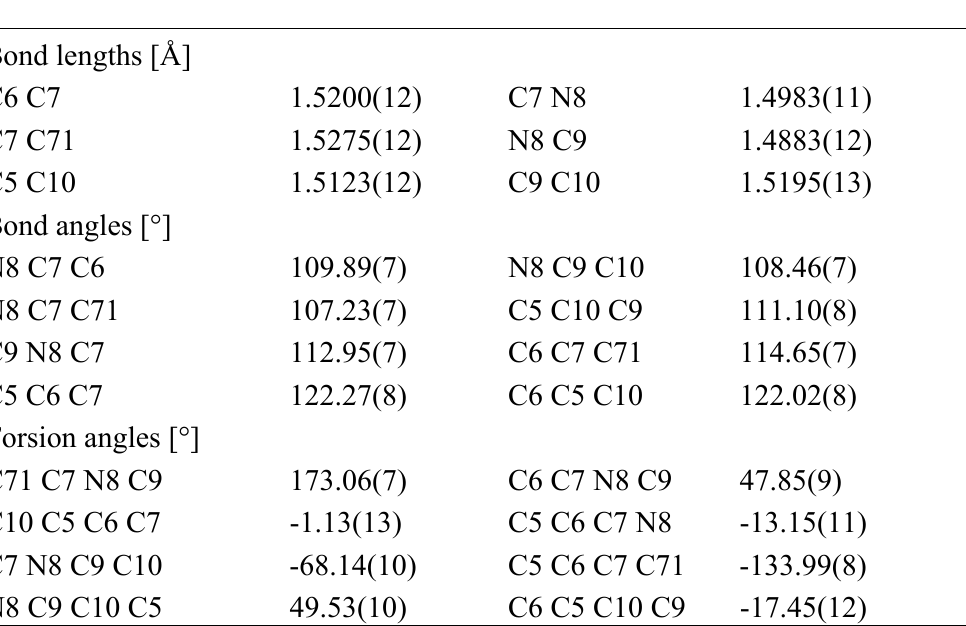
Table 2. Selected bond lengths and angles of 2